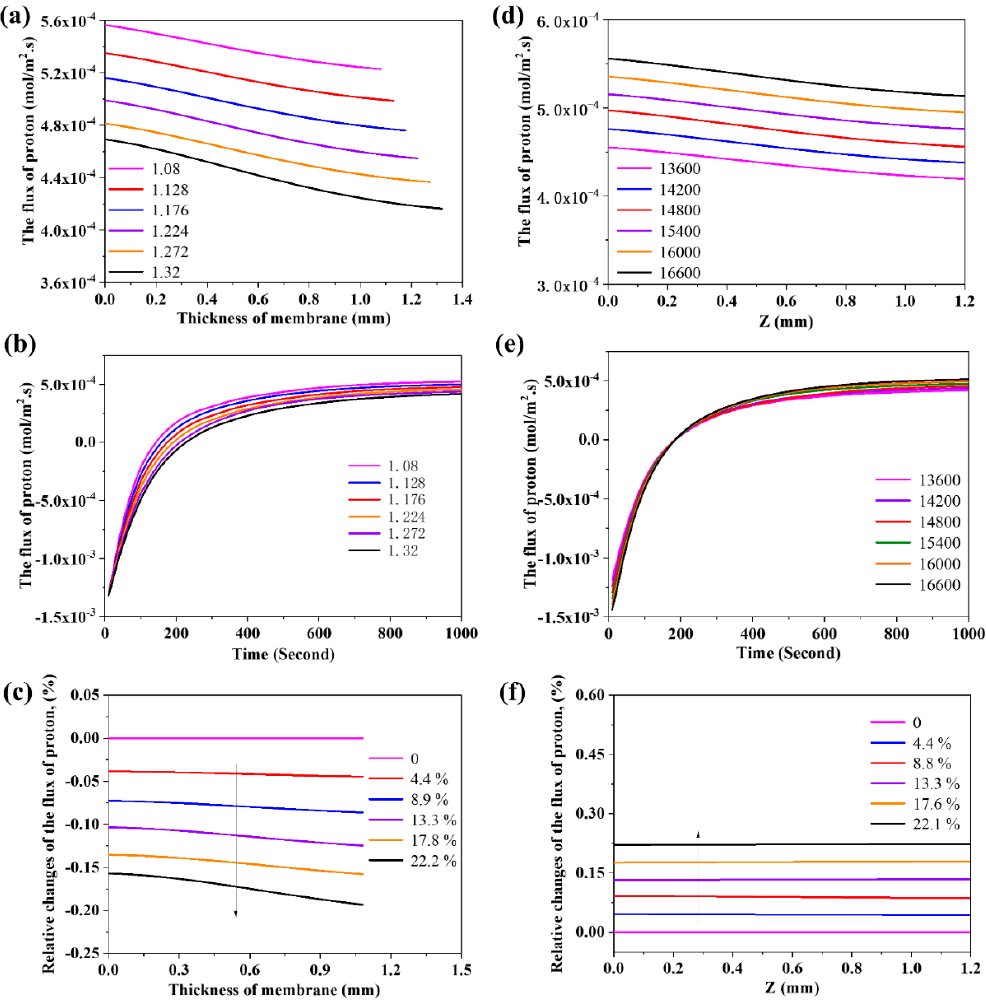
Figure 6. ( a ) The effect of thickness of membrane on the flux of proton; ( b ) the effect of thickness of membrane on the evolution of flux of proton; ( c ) normalized analysis of the effect from thickness of membrane on the flux of proton; ( d ) The effect of density of membrane on the flux of proton; ( e ) the effect of density of membrane on the evolution of flux of proton; and ( f ) normalized analysis of the effect from density of membrane on the flux of proton.